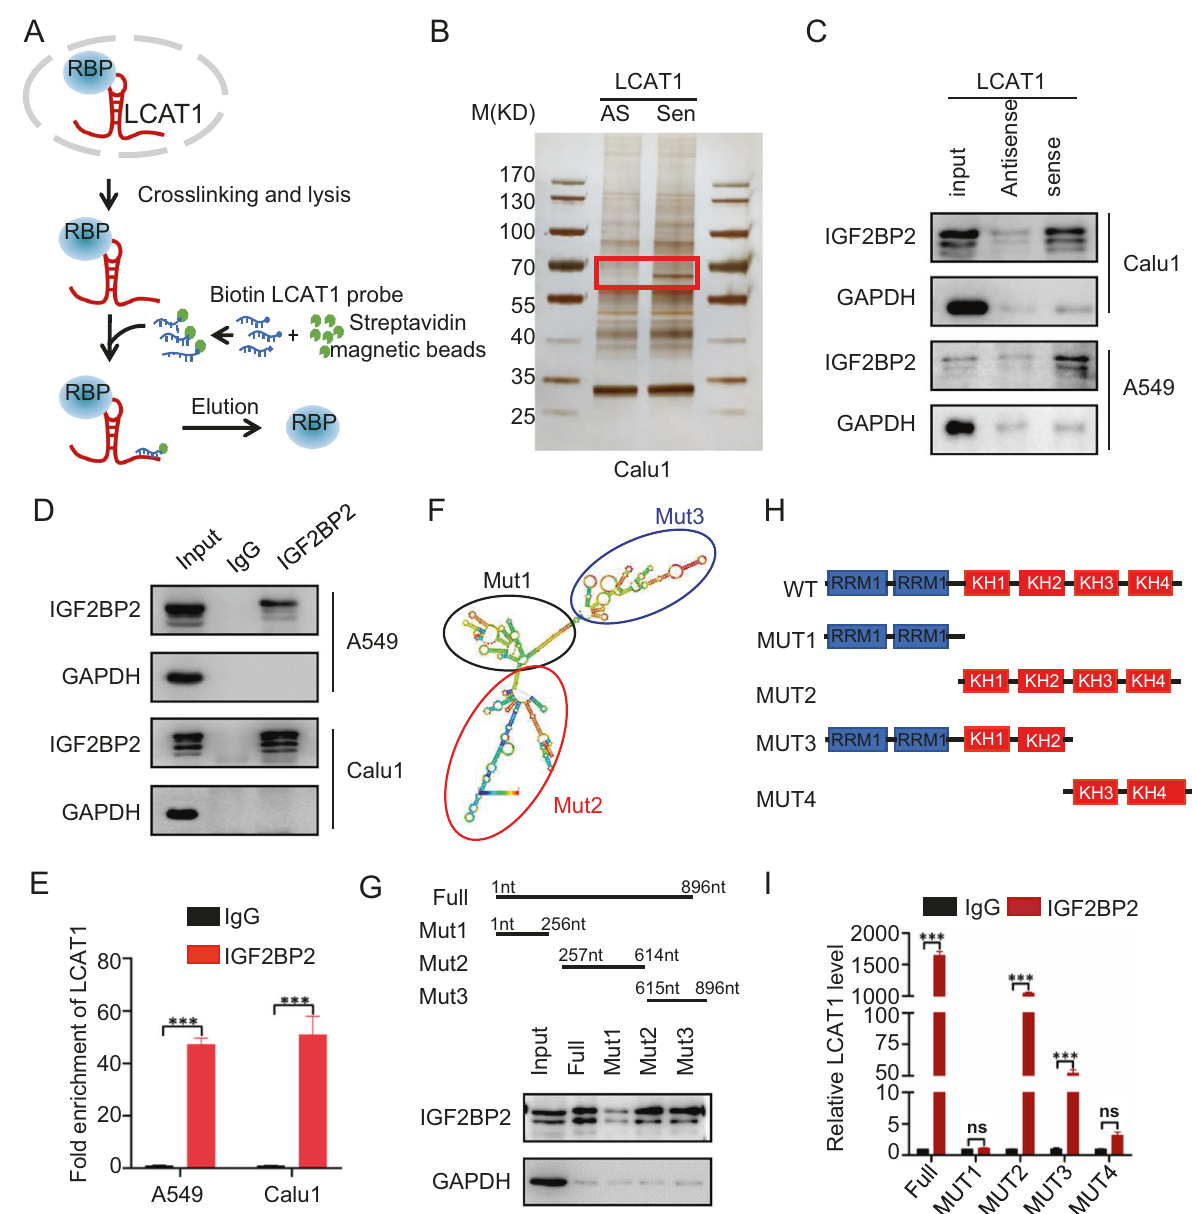
Fig. 1 LCAT1 physically interacts with the m 6 A reader protein IGF2BP2 in lung cancer cells. A Schematic diagram of RNA pull-down assay. B Proteins were pull-downed by LCAT1 antisense/sense probes followed by silver staining. C Immunoblotting to con fi rm the speci fi c interaction between LCAT1 and IGF2BP2. GAPDH was used as a negative control. D , E RIP assays were performed using the anti-IGF2BP2 antibody to reversely verify the LCAT1-IGF2BP2 interaction. qPCR was used to determine LCAT1 enrichment. F The secondary structure of LCAT1 predicted by RNAfold webserver. G Western blot was used to detect IGF2BP2 protein pulled down by different mutants of LCAT1. H Structural diagram of different IGF2BP2 mutant proteins. I RIP assays were conducted using anti-FLAG antibodies to detect the enrichment of LCAT1 in different IGF2BP2 mutants. H Western blot was used to detect the IGF2BP2 protein level in LCAT1 knockdown and control cells. The data were presented as the mean ± SD; n = 3; Student ’ s two-sided t -test were used, * P < 0.05, ** P < 0.01, *** P <